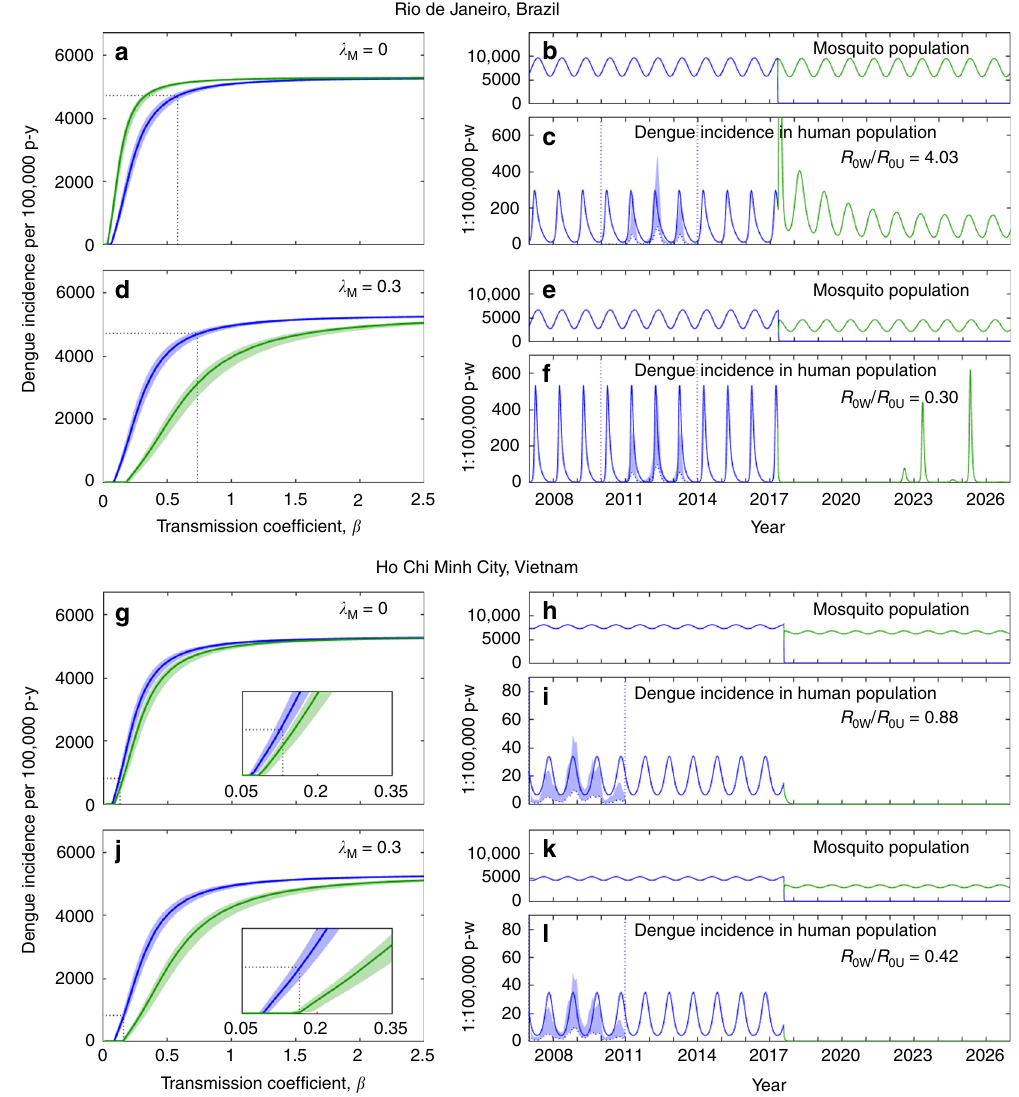
Fig. 3 Projected impact of Wolbachia on dengue transmission in human populations. Colours indicate whether transmission is by Wolbachia -free (Wolb − , in blue) or Wolbachia -carrier (Wolb + , in green) mosquitoes. Left panels show dengue incidence versus transmission coef fi cient plotted from equilibrium solutions of a 4-serytope dengue model (Methods section) on human populations with heterogeneous risk (variance-to-mean ratio of 4): a , d mosquitoes parameterized from experiments in Brazil and released under different forces of selection by mosquito pathogens: a λ M = 0; d λ M = 0.3. g , j same as a , d , for Vietnam. Equilibrium curves adopted mean proportions of infected mosquitoes with detectable virus in the salivary glands 3 , and shaded areas represent lower and upper bounds encountered when mosquitoes were strati fi ed by challenge dose. Dotted lines mark dengue incidence in Rio de Janeiro, and Ho Chi Minh City, averaged over a 4-year period and scaled by an expansion factor of 5. Right panels show model simulations of Wolbachia releases taking place in 2017, starting from the conditions on the respective left panels: b , e , h , k mosquito population sizes; c , f , i , l dengue epidemics in humans (shaded areas refer to noti fi cation data; lower bound showing the original data and upper bound the data multiplied by an expansion factor of 5). Parameter values: β = 0.59 ( c ), β = 0.74 ( f ), β = 0.13 ( i ), β = 0.17 ( l ); A = 0.25, Β = 0.25 ( b , c , e , f ); A = 0.05, Β = 0.1 ( h , i , k , l